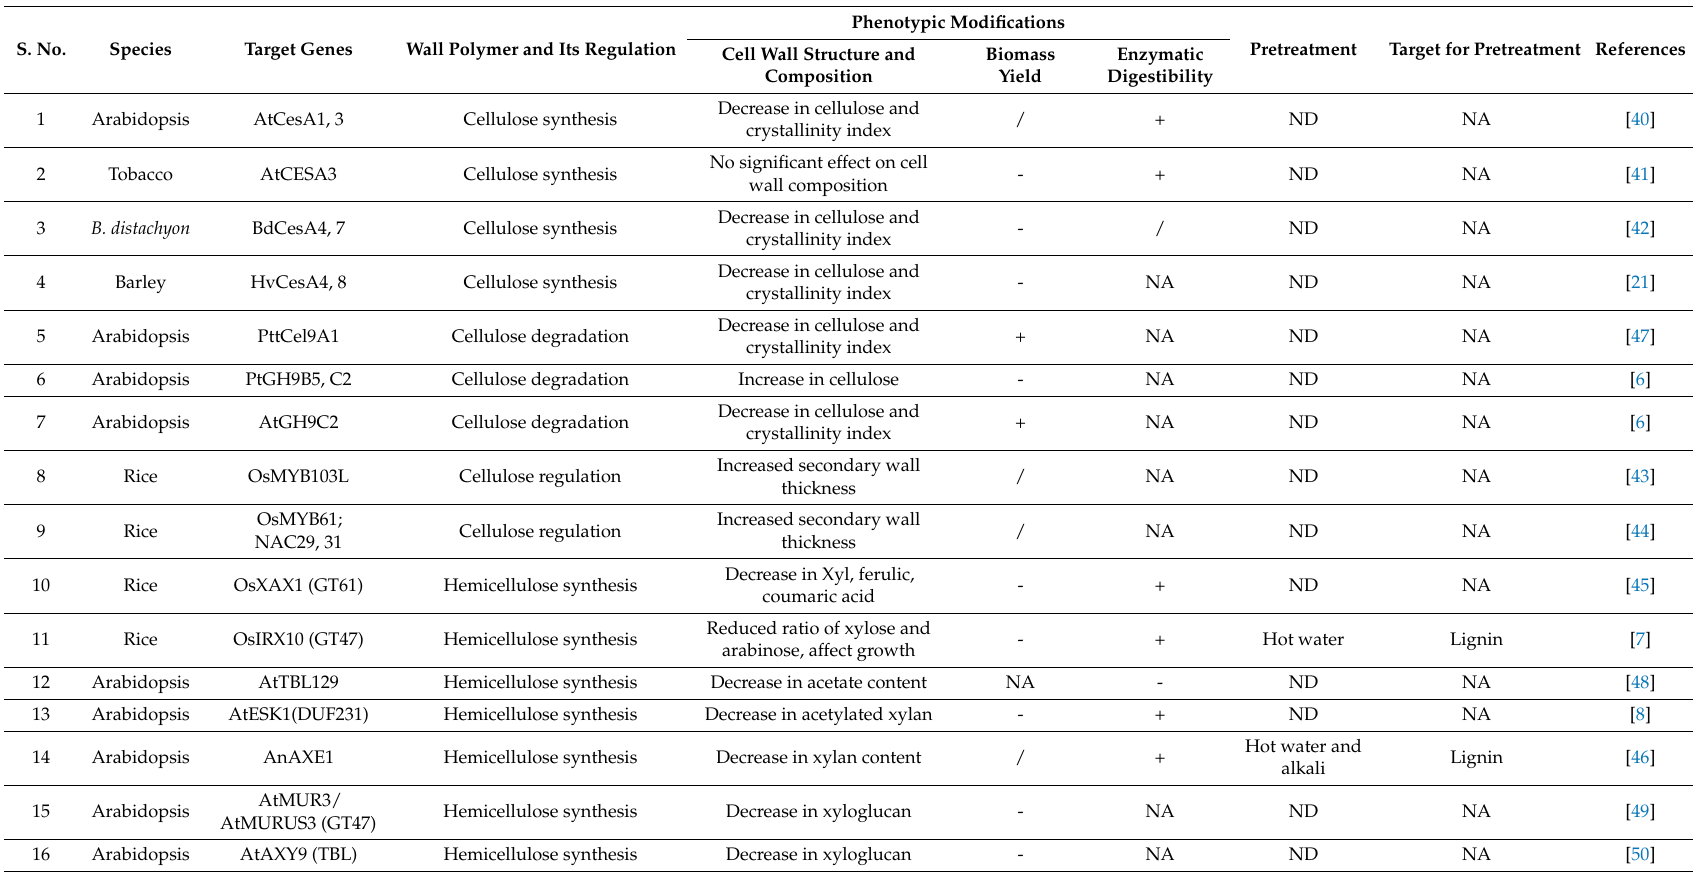
Table 2. Wall polymers and genetic approaches for their